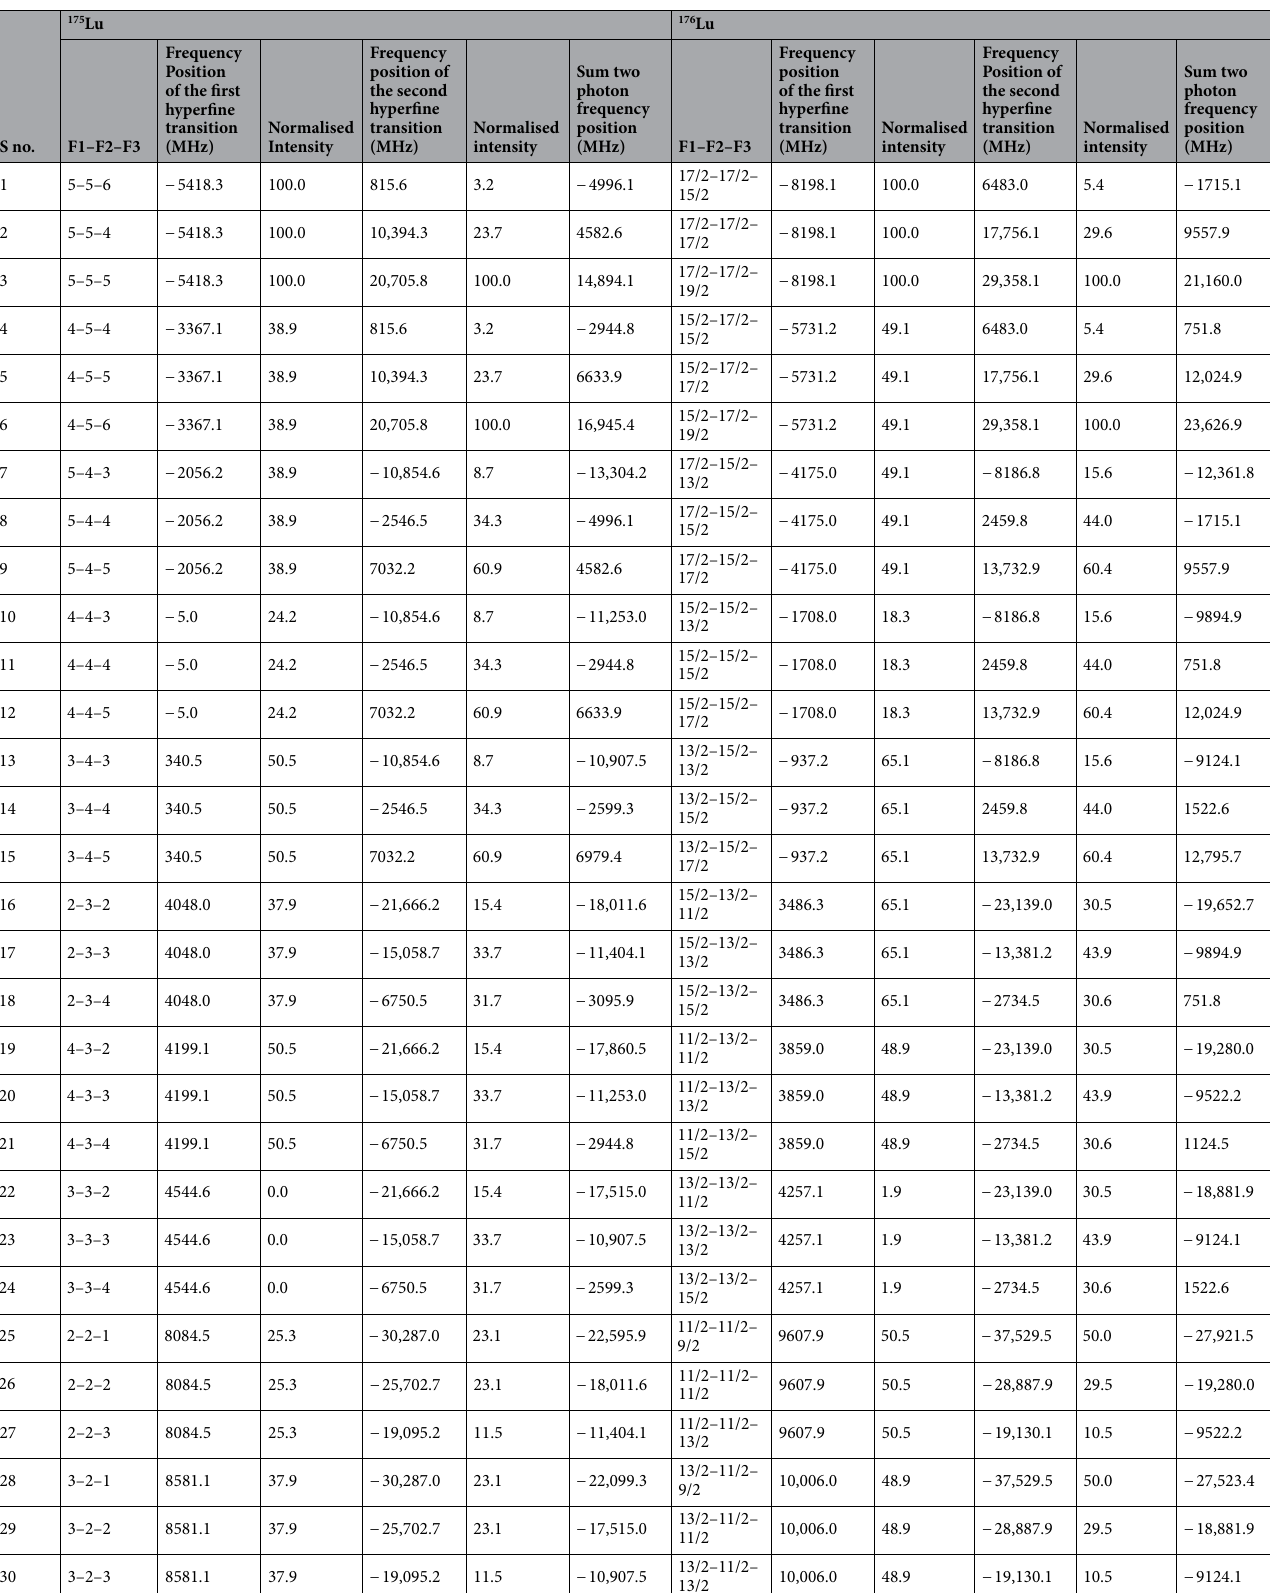
Table 2. A table of hyperfine excitation pathways of 175 Lu and 176 Lu of the photoionization (the frequency position is with reference to the centre of gravity of 176 Lu